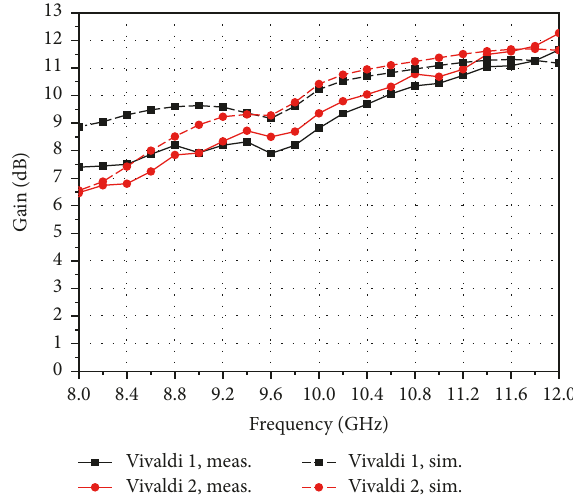
Figure 12: Simulated and measured gain for Vivaldi 1 and Vivaldi